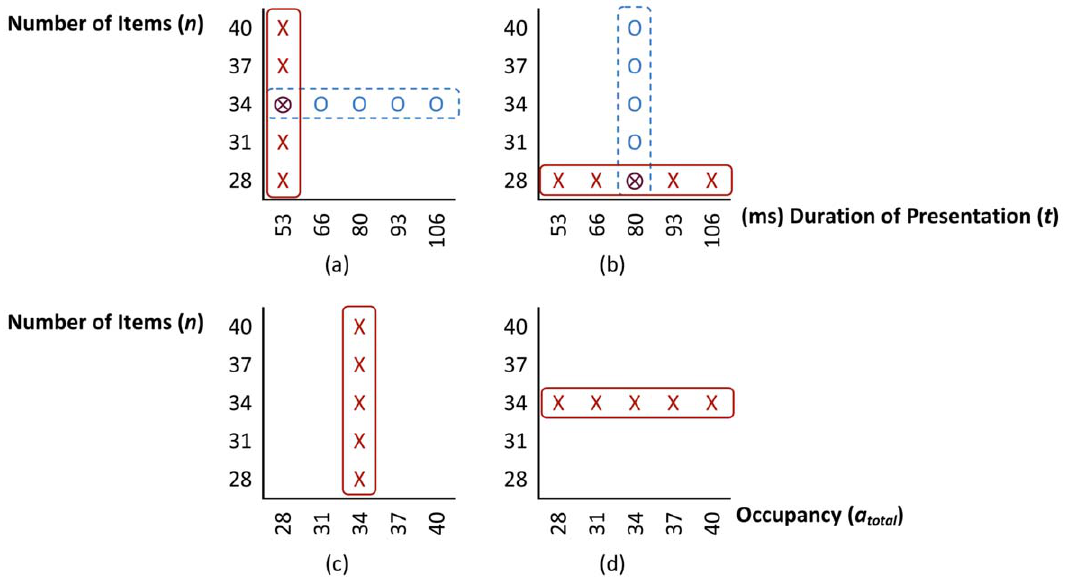
Figure 1. Combination of the numerosity and duration of presentation in each experiment. The number of items of a set and duration of the presentation of a set in (a) numerosity judgement experiment, (b) duration judgement experiment, (c) numerosity judgement phase and (d) a i represents total occupied area scaled to the area of one standard item. occupancy judgement phase in the control experiment. a total ~ P n i ~ 1 Symbols in the solid and dashed bars refer to ‘veridical’ and ‘phantom’ conditions, respectively (refer to the text).